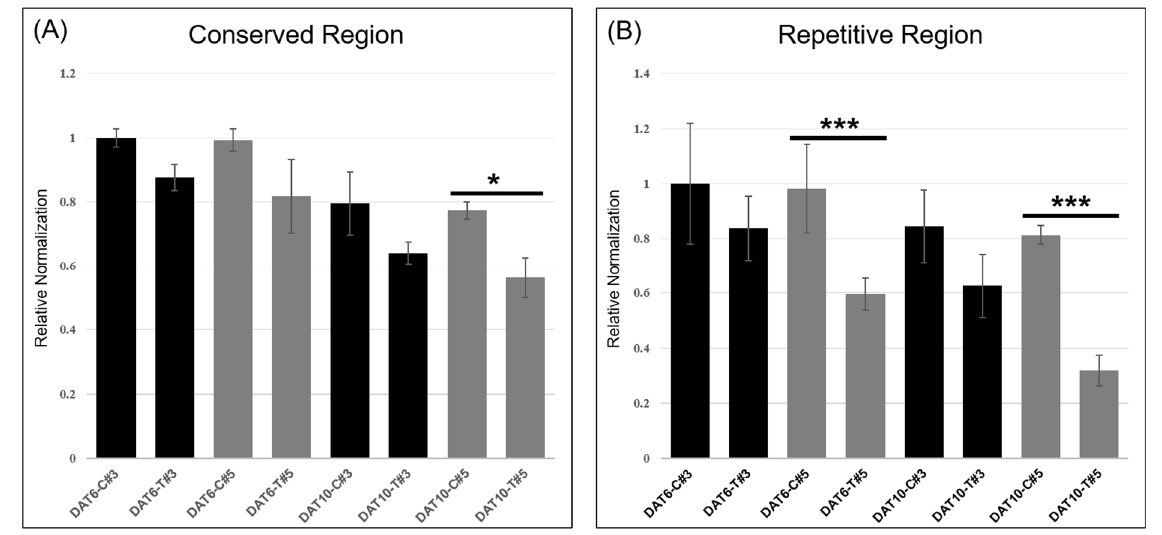
Figure 9. qRT-PCR of spikelets taken from different locations along the spike (position #3 or 5), targeting the conserved ( A ) or repetitive ( B ) region of TaHMW1D . * p < 0.05; *** p < 0.001.